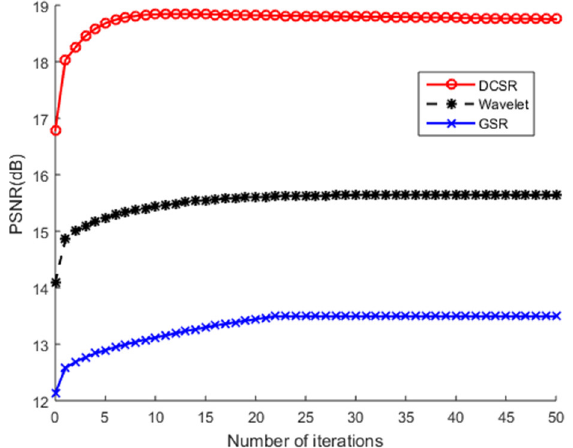
Figure 13. PSNR values of the recovered Lena color image by the competing methods vs. iteration number. The test image is corrupted by AWGN.